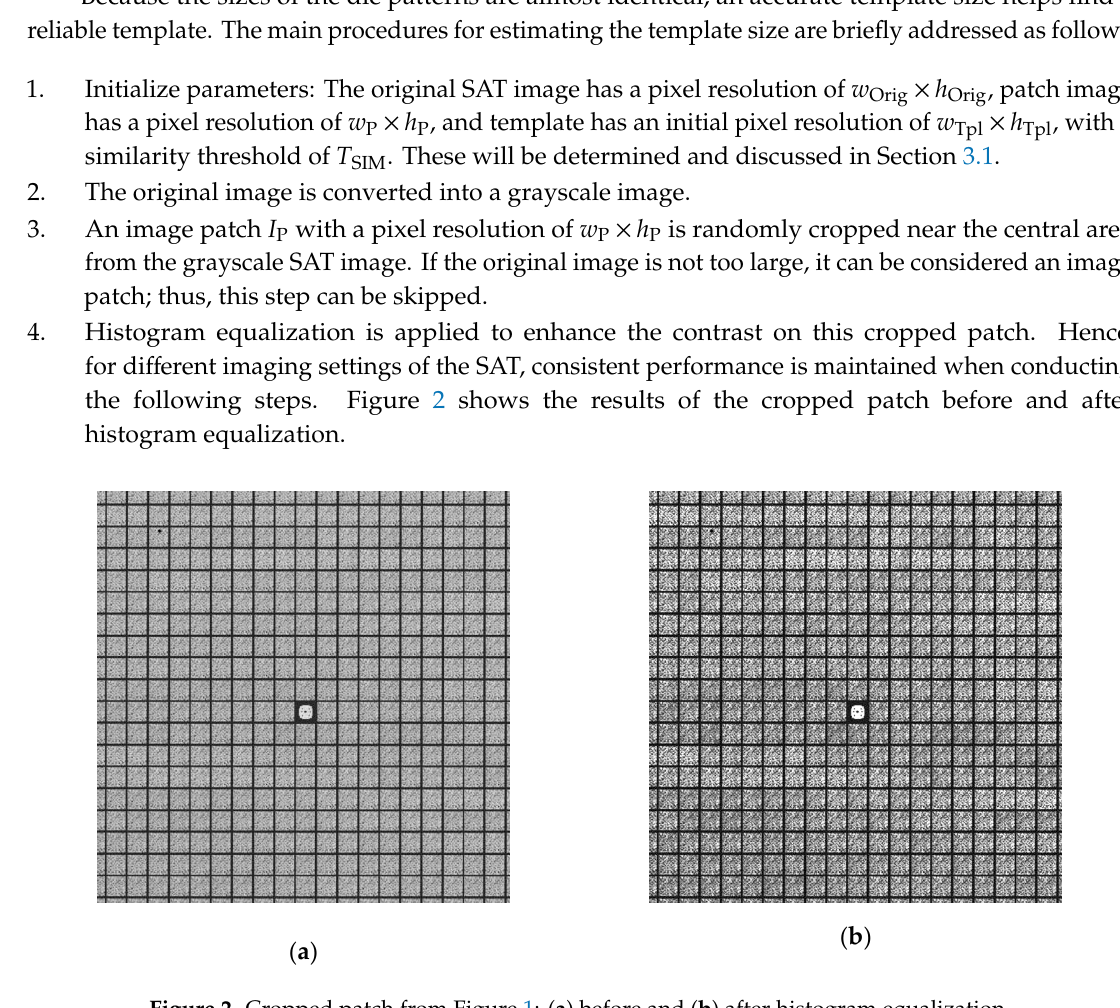
Figure 1. Original scanning acoustic tomography (SAT) image: example wafer.